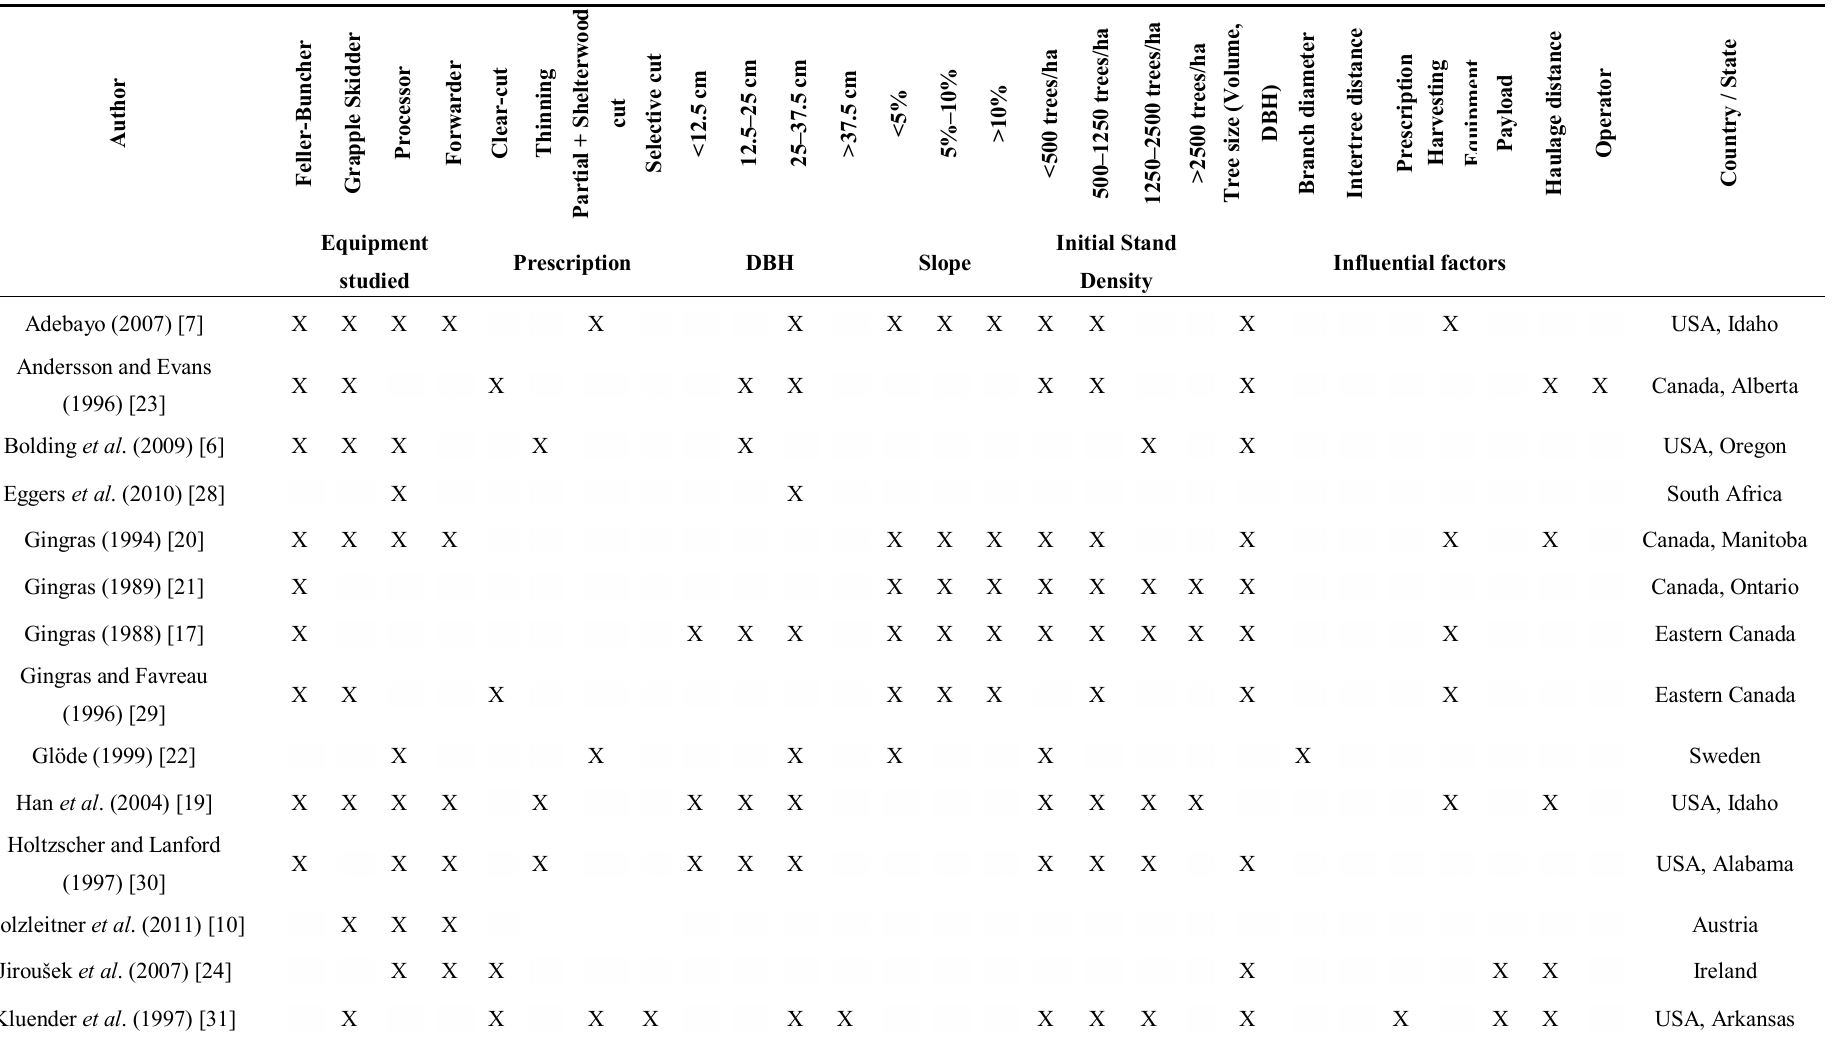
Table 1. Reviewed literature and summary of specific harvest information; The applicability of items in the column heading to the individual publications is marked with an